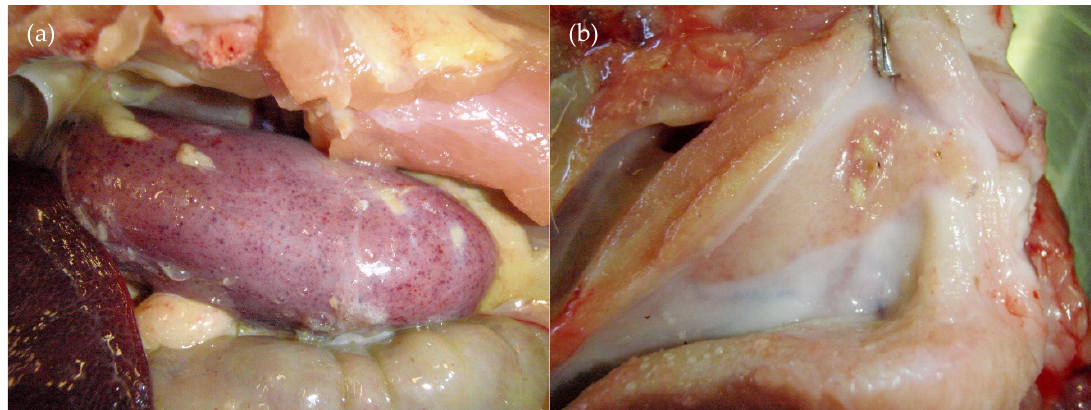
Figure 3. Necropsy findings from D35: ( a ) petechiation of a kidney (17-03—same pig as Figure 1e,f) and ( b ) ulcerated tonsil (16-07).